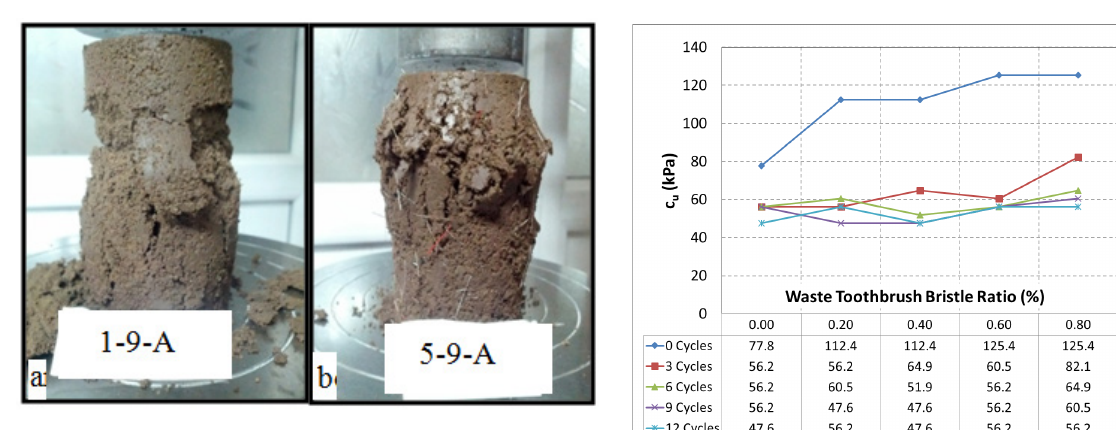
Figure 5: Waste toothbrush bristle ratio vs. undrained shear